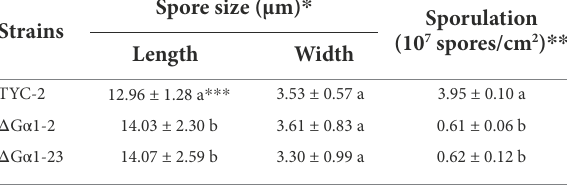
TABLE 2 Spore size and sporulation of Colletotrichum asianum wild- type strain TYC-2 and CaG α 1 gene mutants.